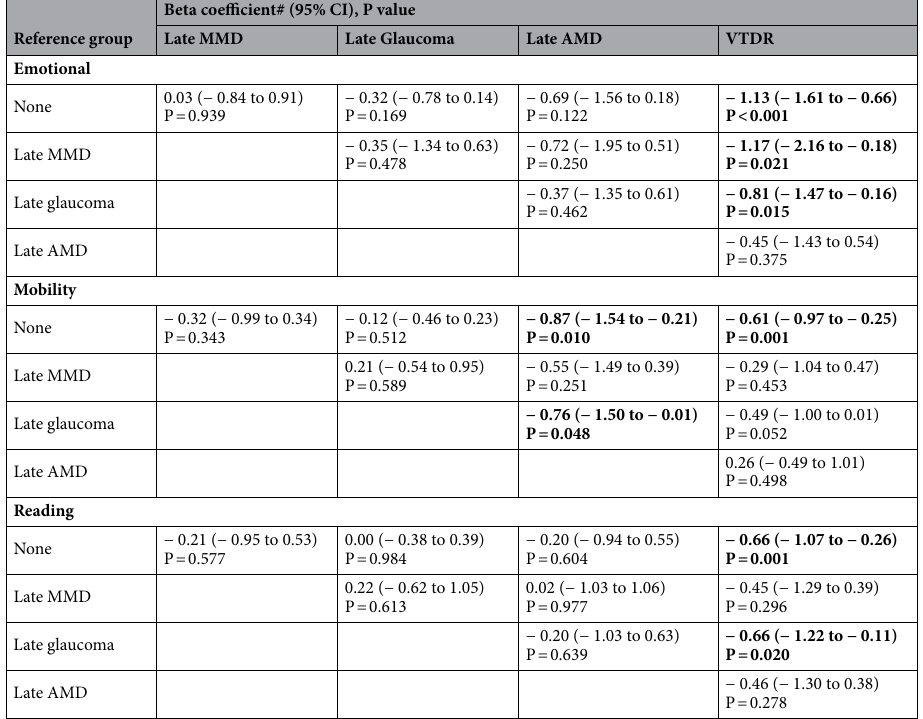
Table 4. Multivariable-adjusted pairwise comparisons of each IVI domain between late stage eye diseases. Adjusted for age, gender, race, education, income, housing, BMI, smoking, alcohol, any systemic disease & PVI better eye. Systemic diseases include diabetes mellitus, arterial hypertension, hyperlipidaemia, CVD & CKD. Significant values are in [bold]. BMI body mass index, CVD cardiovascular disease, CKD chronic kidney disease, PVI presenting visual impairment, VTDR vision threatening diabetic retinopathy, AMD age related macular degeneration, MMD myopic macular